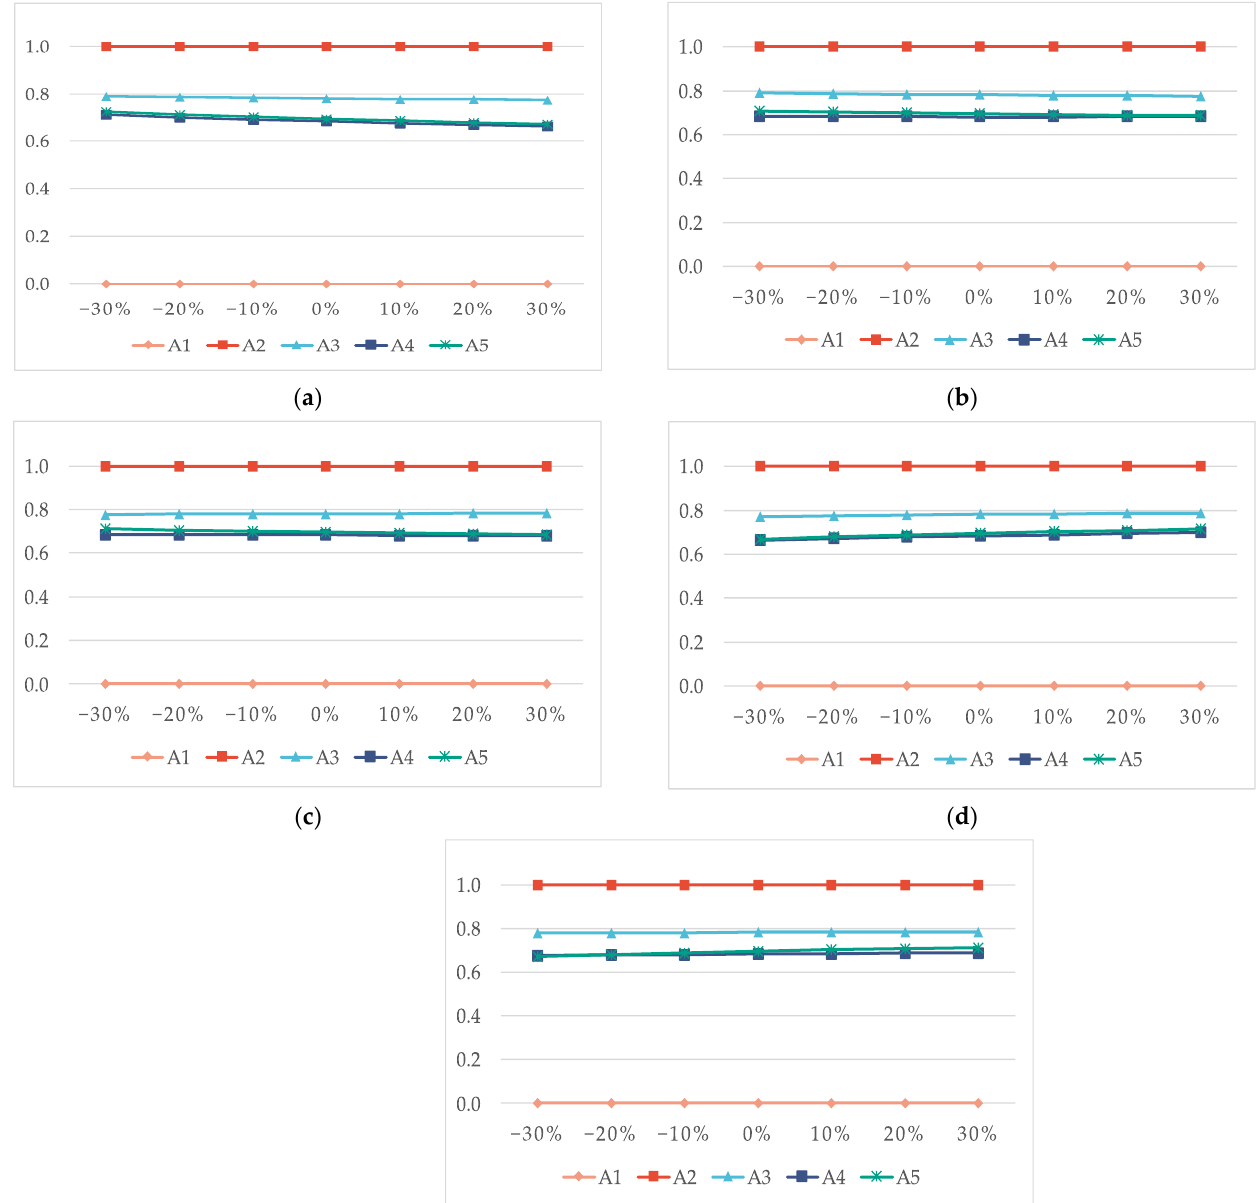
Figure 7. Weight sensitivity analysis results. ( a ) C1 weight fluctuation; ( b ) C2 weight fluctuation; ( c ) C3 weight fluctuation; ( d ) C4 weight fluctuation; ( e ) C5 weight fluctuation.